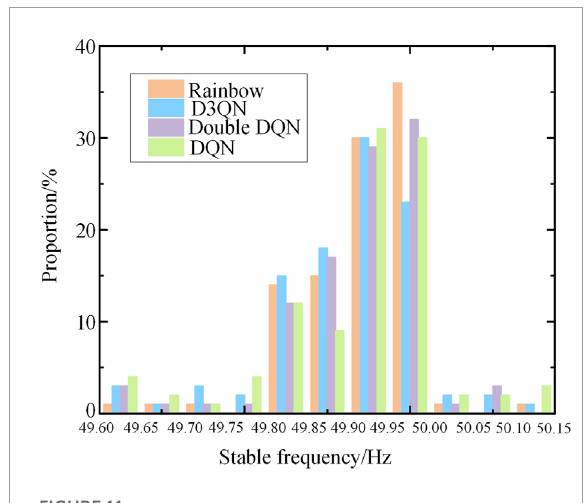
FIGURE 11 Frequency distribution at the time of system stability in different test